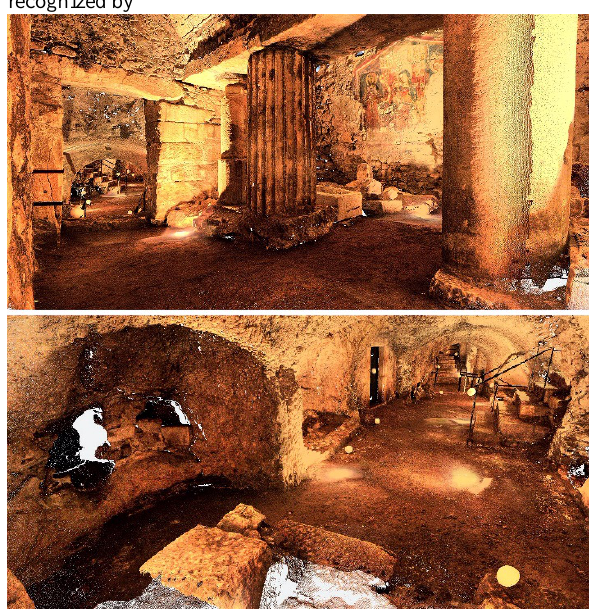
Figure 4. Laser scanner cloud points with chromatic component of some central areas of the